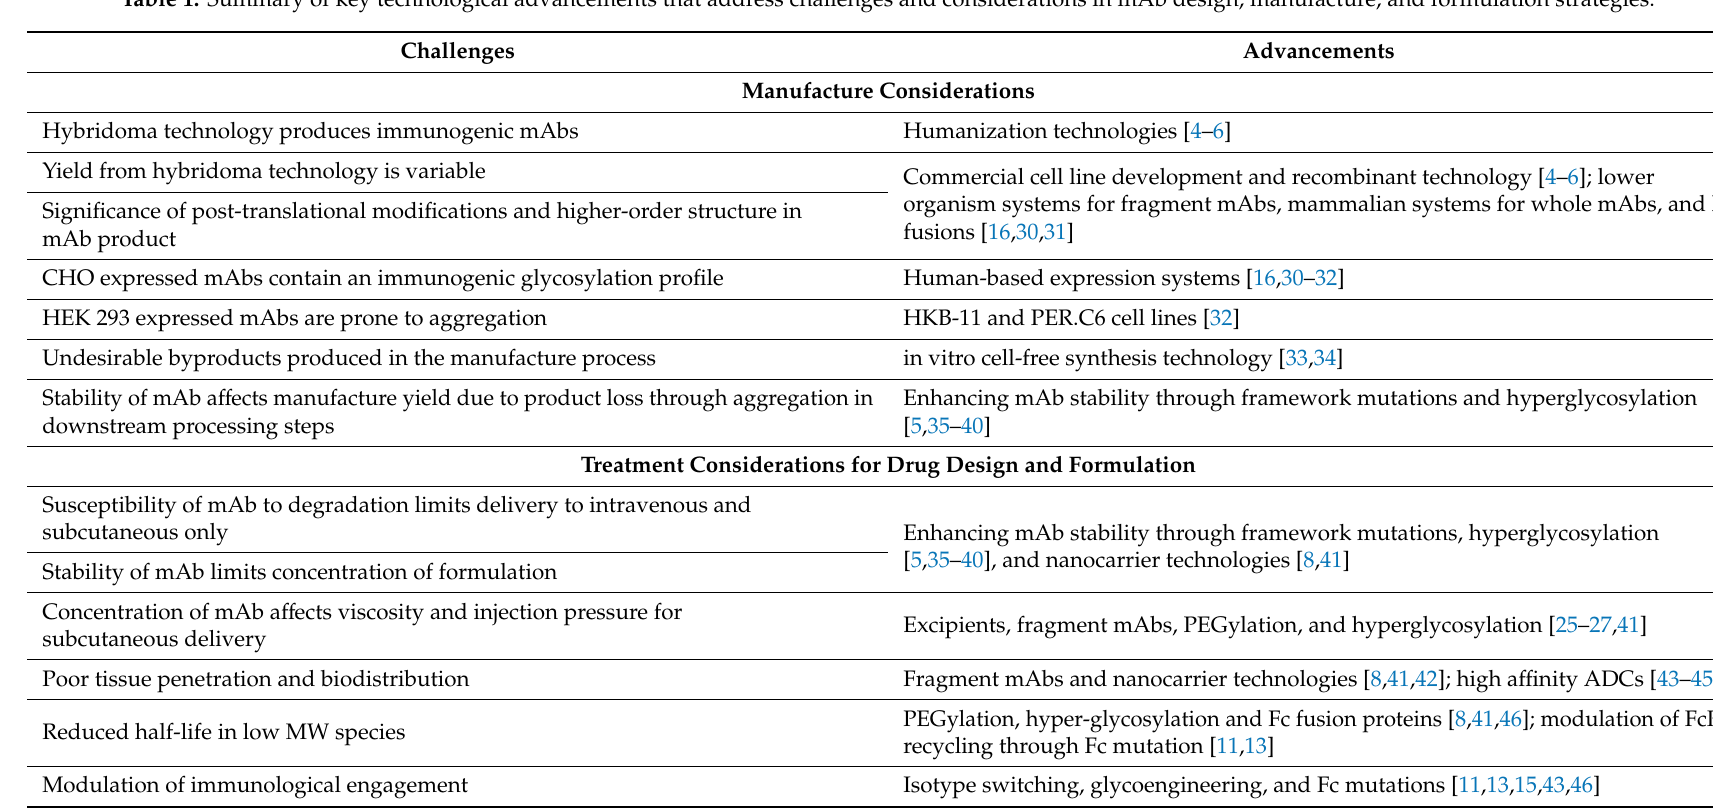
Table 1. Summary of key technological advancements that address challenges and considerations in mAb design, manufacture, and formulation